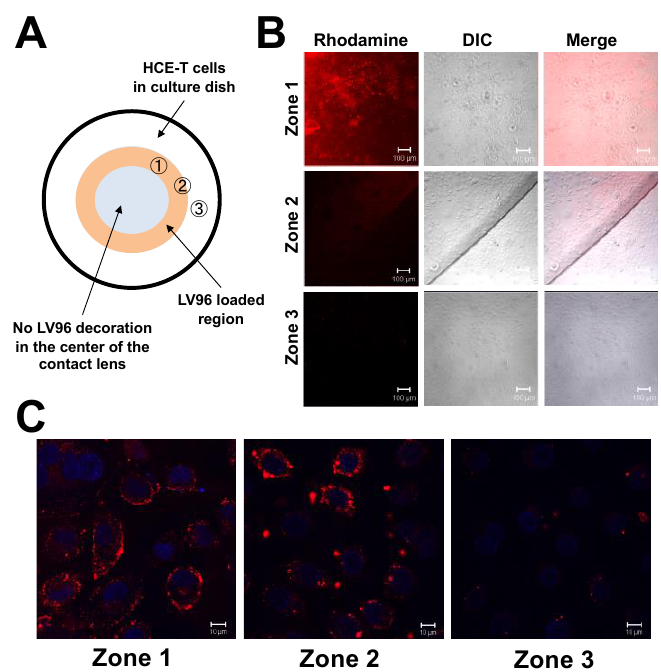
Figure 6. Spatial proximity is required for the e ffi cient transfer of LV96 from Proclear Compatibles TM contact lenses to cultured HCE-T cells. ( A ) Cartoon showing contact lens loaded with a ring pattern of LV96 with three zones indicated: 1) under the lens; 2) at the edge of the lens, and 3) distal to the lens. ( B ) Confocal imaging was performed to confirm the location of the rhodamine-labeled LV96 bound to a lens above cultured HCE-T cells, which were incubated for 1 h at 37 ◦ C in complete media. Bar = 100 µ m. ( C ) High magnification images show e ffi cient association of rhodamine-labeled LV96 with cultured HCE-T cells in zones 1 and 2. In zone 3, less labeling was apparent. Red: rhodamine-labeled LV96; Blue: DAPI-stained nuclei. Bar = 10 µ m. Images shown are representative from at least three independent experiments.